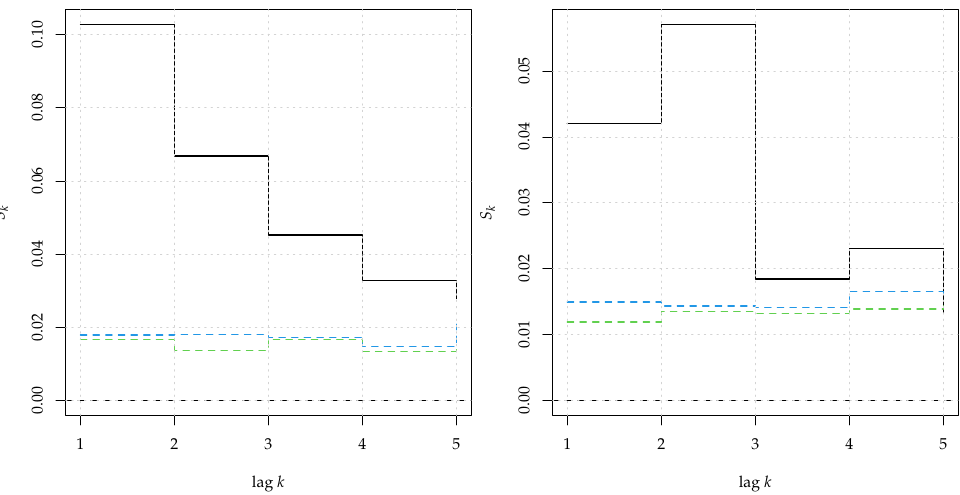
Figure 14. Serial entropy S k for k = 1, . . . ,5 (black, solid line), computed on a realization of a linear ARMA(1,1) process (left panel) and on the residuals of a fitted MA(1) model upon the series (right panel). The rejection bands at 95% (green dashed line) and 99% (blue dashed line) corresponded to the null hypothesis of serial independence.